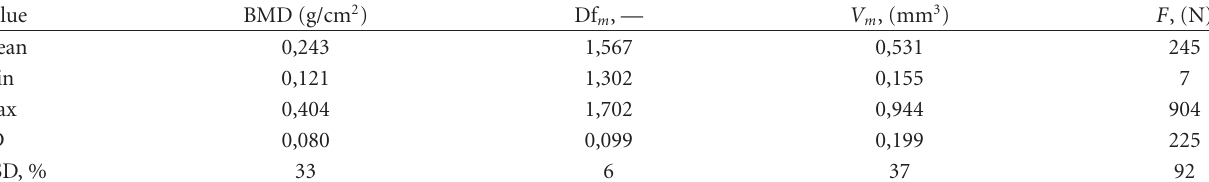
Figure 2: Numerical analysis of bone structure: (a) mesh; (b) schema of boundary condition. Table 1: Bone mineral density, fractal dimension and volume of the bone layer related to applied force.